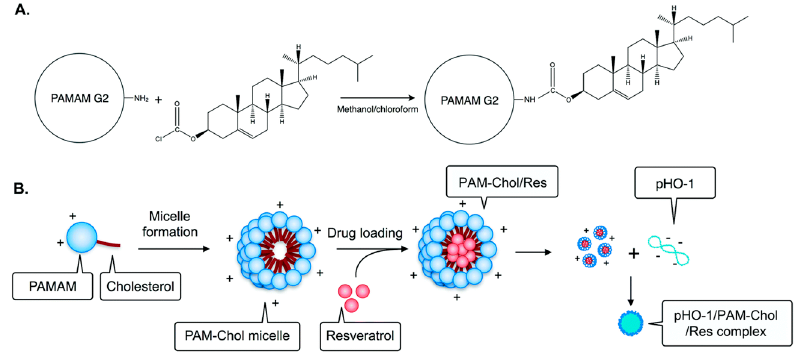
Figure 9. Synthesis of cholesterol-conjugated PAMAM (PAM-Chol) ( A ) and preparation of the pHO-1 / PAM-Chol / Res complex ( B ). The heme oxygenase-1 gene (pHO-1). Adapted from reference [269]. Copyright 2018 Royal Society of Chemistry.